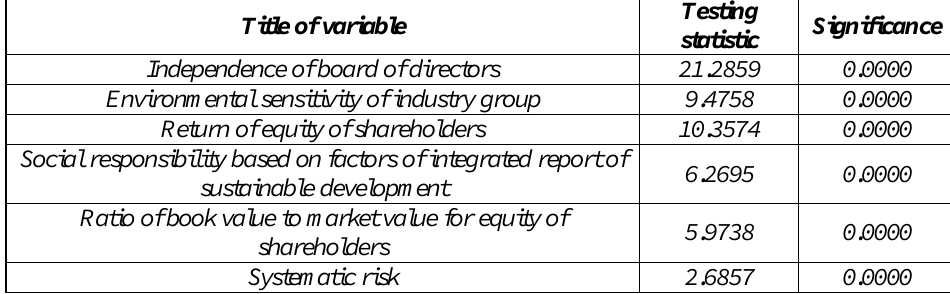
Table 3. The resultant findings from Hadri test